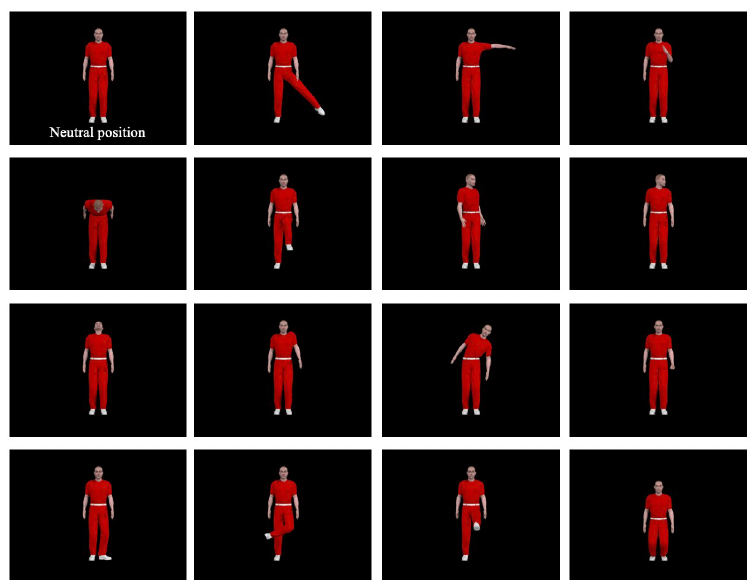
Fig 1. Human action clips used in Experiment 1 and 2. All clips were used in Experiment 2, whereas only 12 of them were used in Experiment 1. Each image is the midpoint of the action clip that depicts the largest movement within the entire clip, which starts and ends with the human avatar in a neutral, upright position with arms at the sides and head facing forward (labeled Neutral in the figure). Infants saw only one action clip presented on the screen at a time, and action clips within a triplet played sequentially with no pause in between.